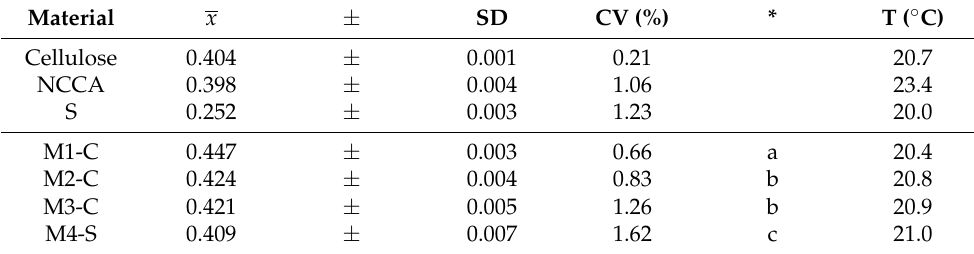
Table 2. a w of raw material and